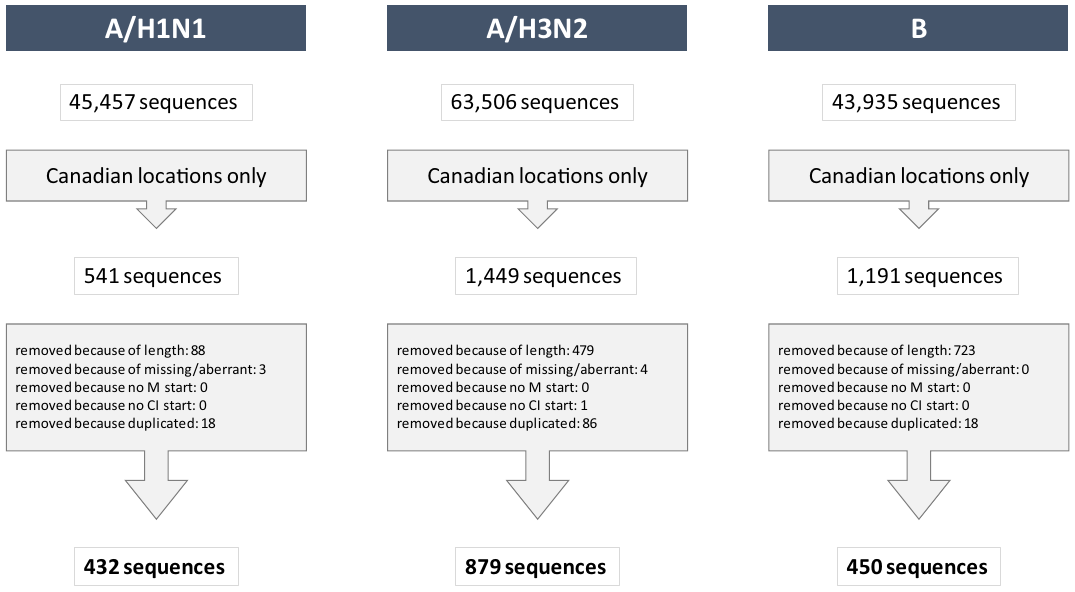
Figure 1. Flowchart for the cleaning process of the genetic sequences for influenza A/H1N1, A/H3N2 and B. The number of sequences at the top represents the total number of sequences downloaded from GISAID, filtering the virus type or subtype only. The number at the bottom represents the final number of sequences used in this